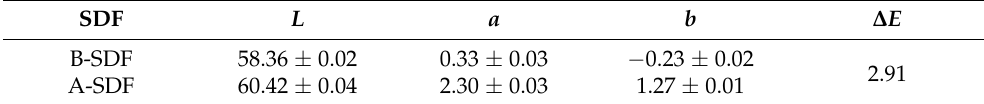
Table 1. Color difference analysis of SDF extracted from glutinous rice bran by different methods.